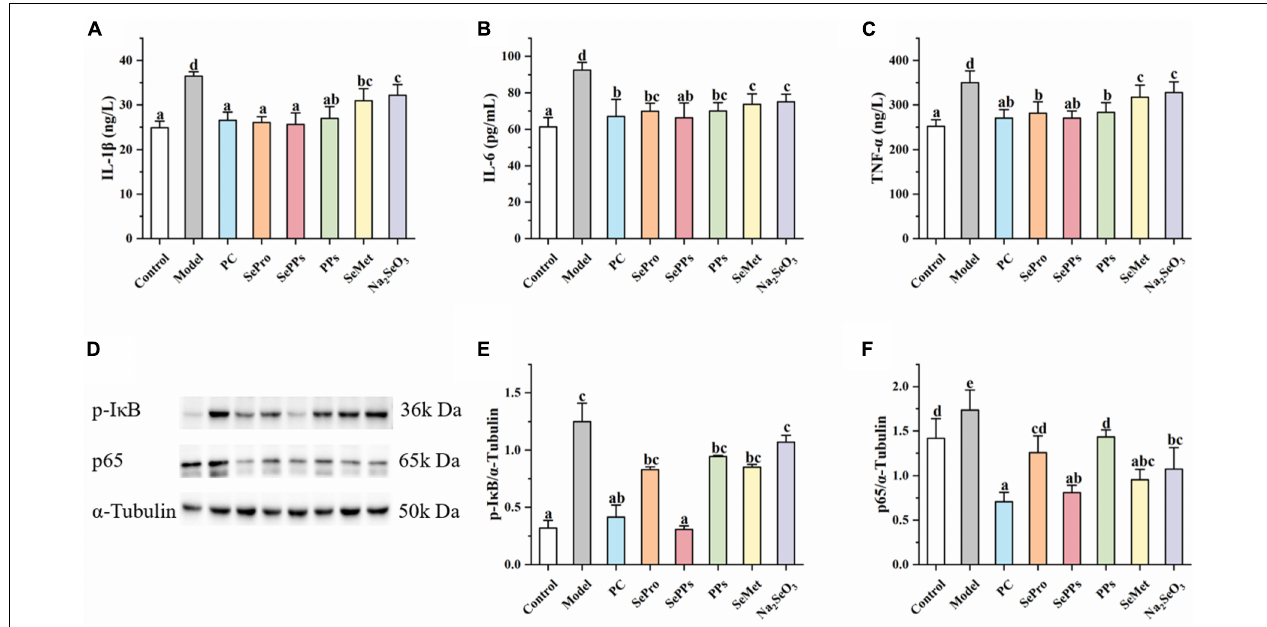
FIGURE 6 | Effects of different selenium supplements on IL-1 β (A) , IL-6 (B) , TNF- α (C) , Western blot analysis (D) , p-I κ B (E) , and p65 (F) in rat liver. Values are expressed as the mean ± SD, results marked with the same letters were not significantly different ( p >